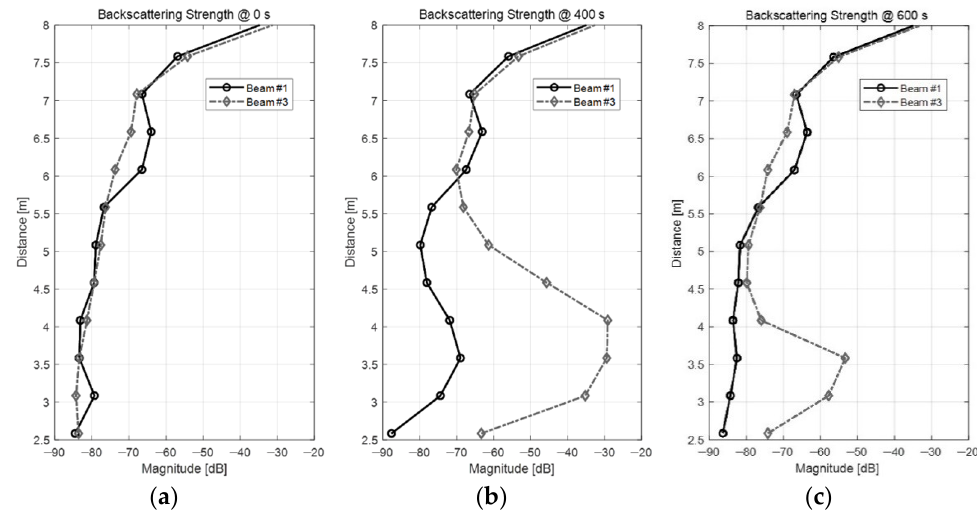
Figure 3. Backscattering strength profiles as a function of depth: ( a ) 0 s; ( b ) 400 s; and ( c ) 600 s.